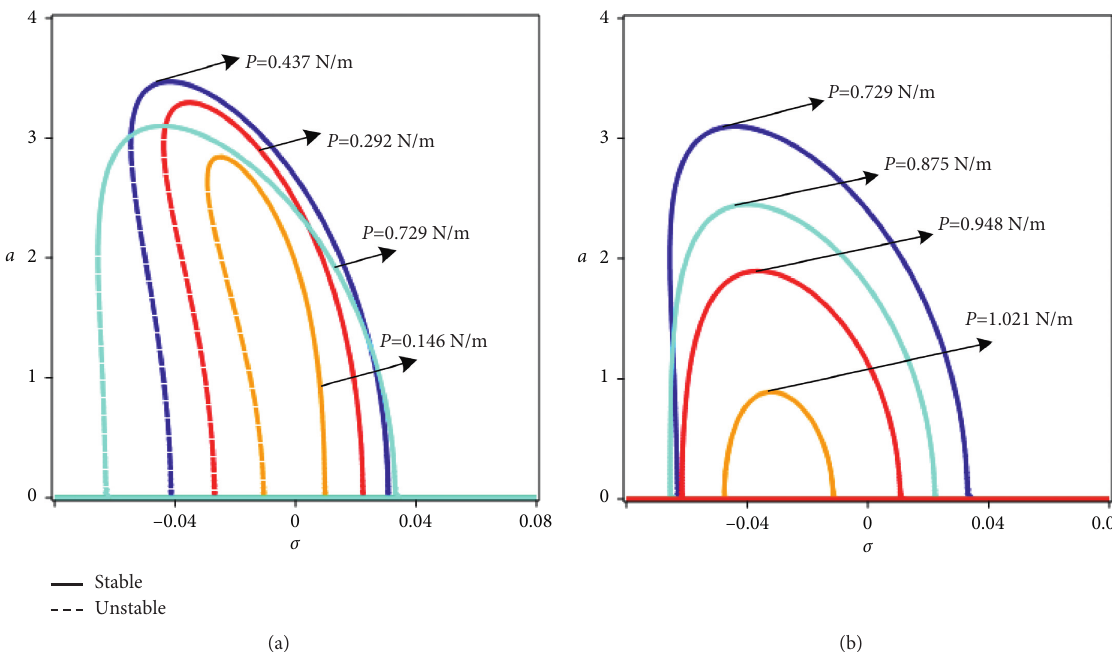
Figure 11: The 1/2-order subharmonic amplitude-frequency response curve (varied P ) with different excitation amplitudes: (a) 0.146–0.729N/m and (b) 0.729–1.021N/m.